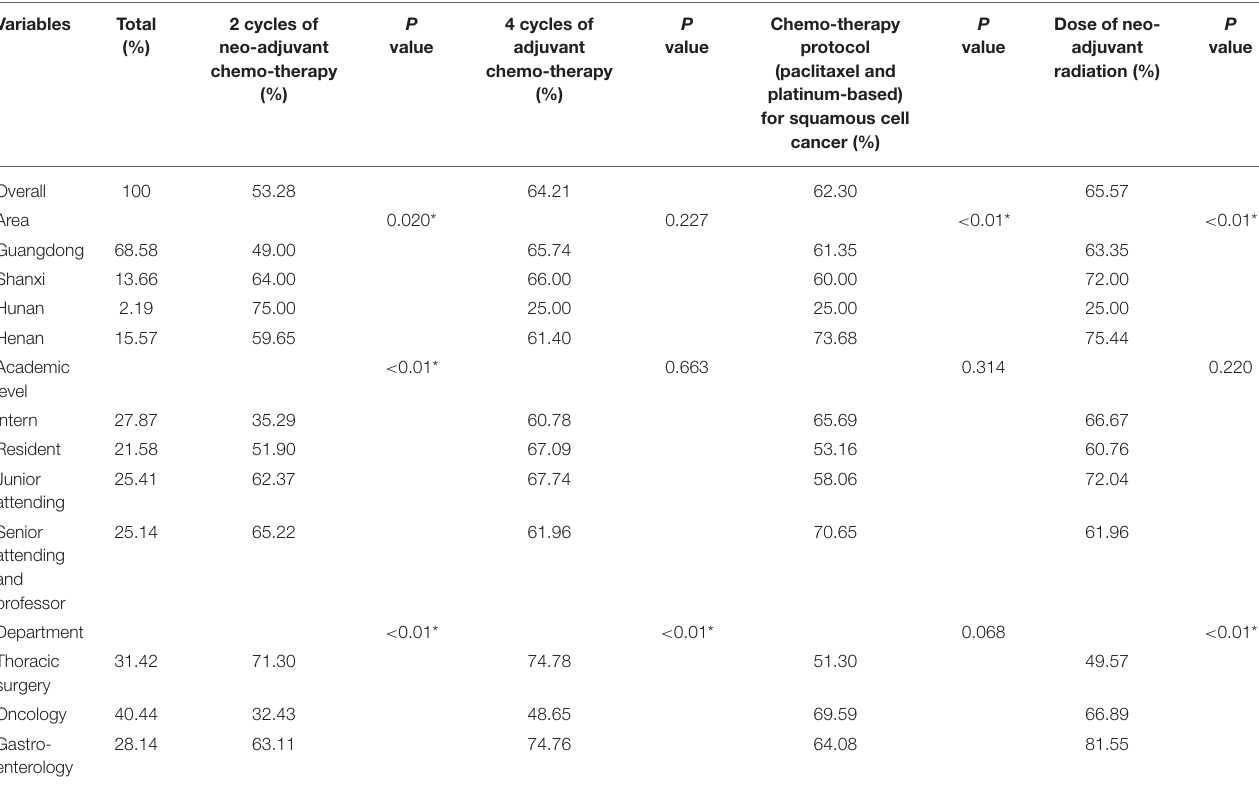
TABLE 2 | Summary of peri-operative therapy decision for esophageal cancer patients in central and southern China (* P < 0.05).